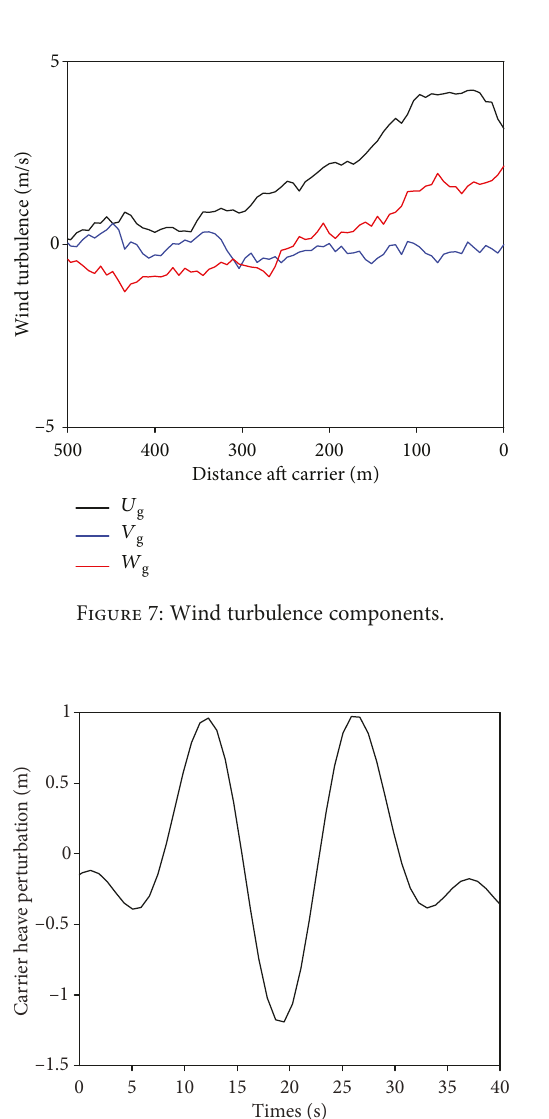
Figure 6: UAV Landing trajectory in the horizontal